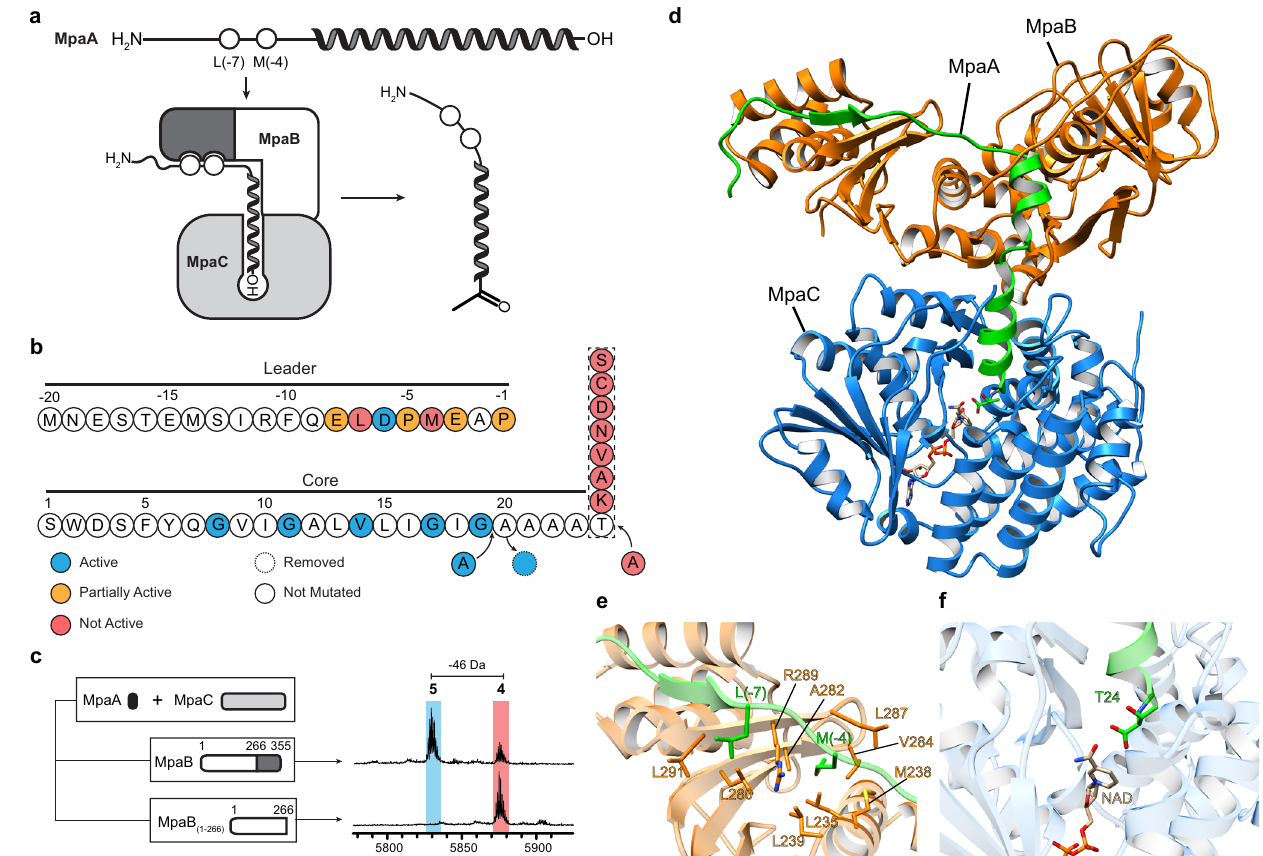
Fig.4|CharacterizationofketoneintermediateformationbyMpaBandMpaC. a Proposed interaction model for MpaA, MpaB, and MpaC. The RRE domain (dark grey)ofMpaB interacts with the conservedleaderregion ofMpaA. The C -terminus (depicted as “ -OH ” ) of MpaA is directed into the active site of MpaC for modi fi ca- tion. b SummaryofMpaAvariantprocessingupon E.coli co-expressionwithMpaB/ C. c Mass spectraofMpaA after co-expression with MpaC, and MpaBor MpaB 1-266 . The RRE domain of MpaB is dark grey. d The structure of MpaA1-MpaB-MpaC